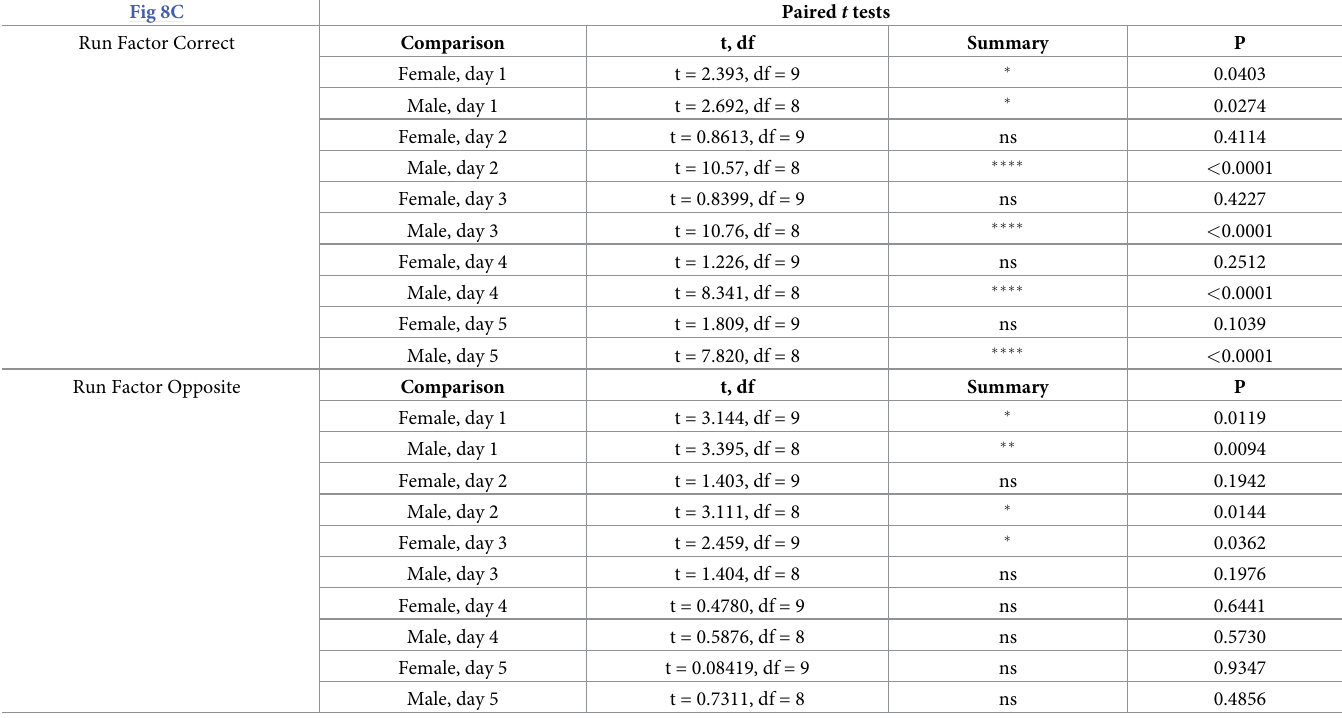
Table 13. Statistical analysis of data shown in Fig 8C for behavioral sequencing, cohort B, Run comparison. Fig 8C Paired t tests Run Factor